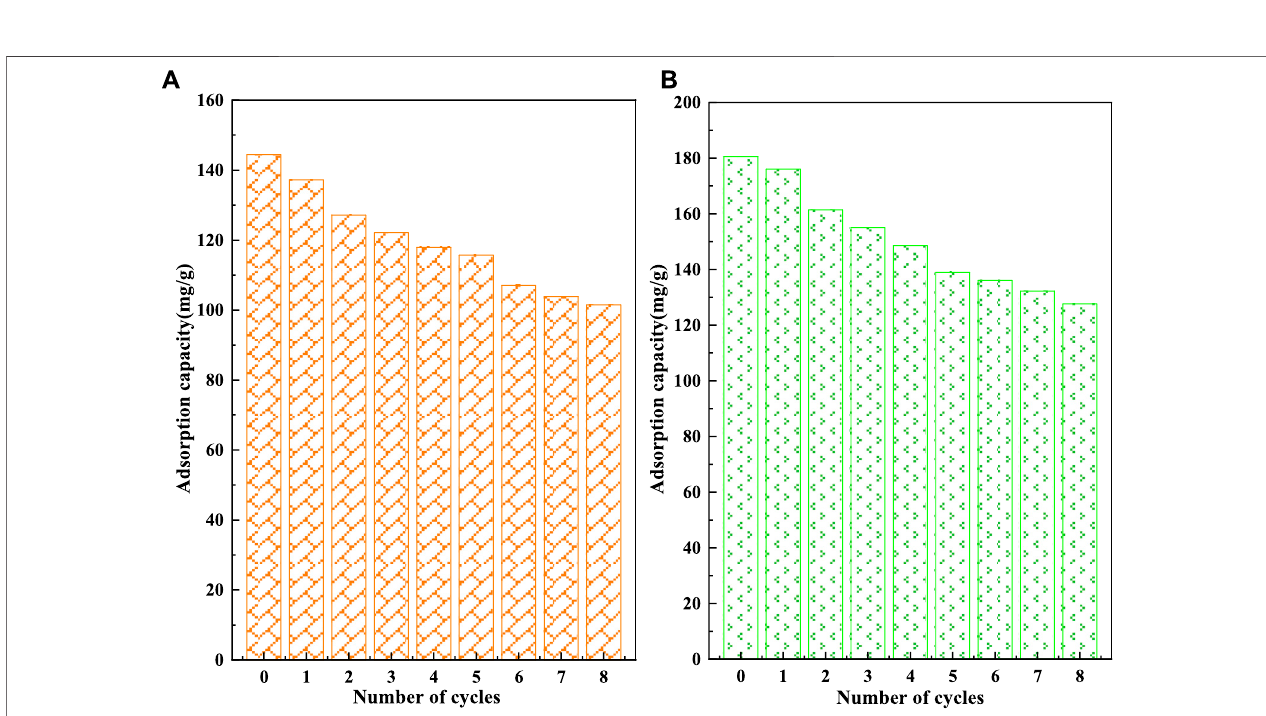
FIGURE 11 | Effect of cyclic adsorption-regeneration runs on the adsorption of fl uoride about C-SAA and C-SAAoa.